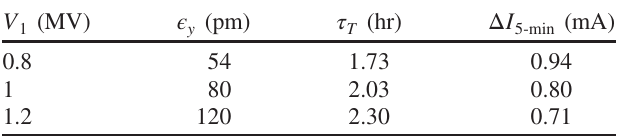
TABLE III. Touschek lifetime, τ , for the tilted bunch with a T 20 mA bunch current and the deflecting voltage of the first frequency, V 1 , at three levels. Also listed are the vertical slice emittance, ϵ and beam loss over the 5-min interval between y